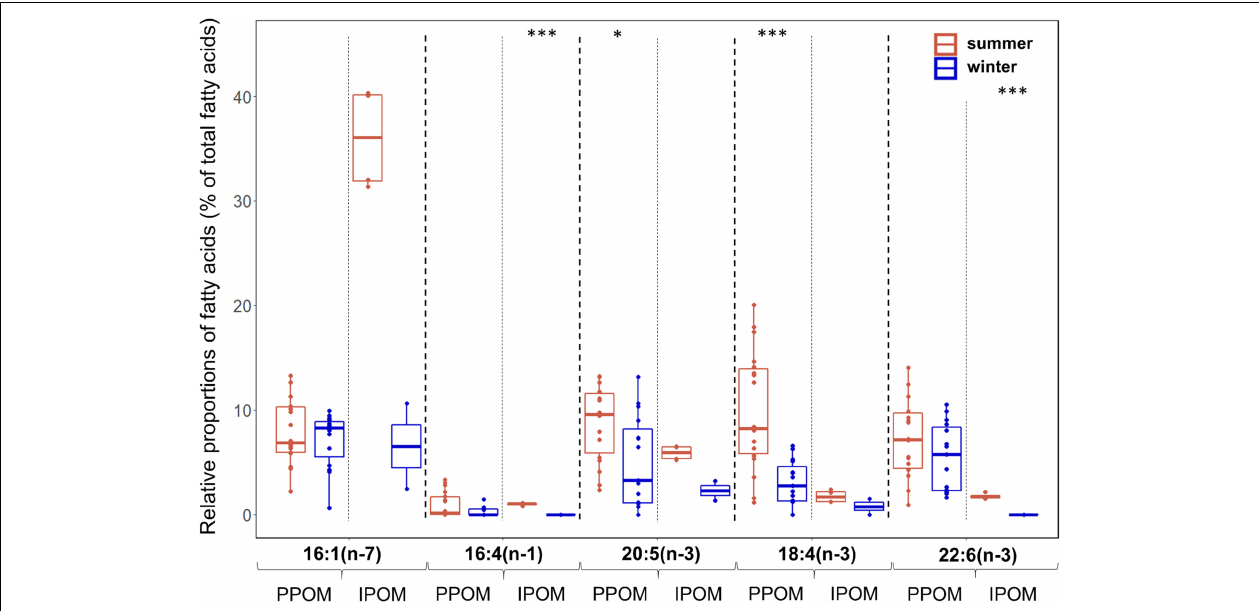
FIGURE 3 | Relative proportions (as % of total fatty acids-FAs) of diatom- [16:1(n-7), 16:4(n-1), 20:5(n-3)] and dinoflagellate-associated marker FAs [18:4(n-3), 22:6(n-3)] during summer (Q3) and winter (Q4) in pelagic particulate organic matter (PPOM) (Q3: n = 15, Q4: n = 18) and ice-associated particulate organic matter (IPOM) (Q3: n = 4, Q4: n = 2). Box plot design is described in Figure 2 .